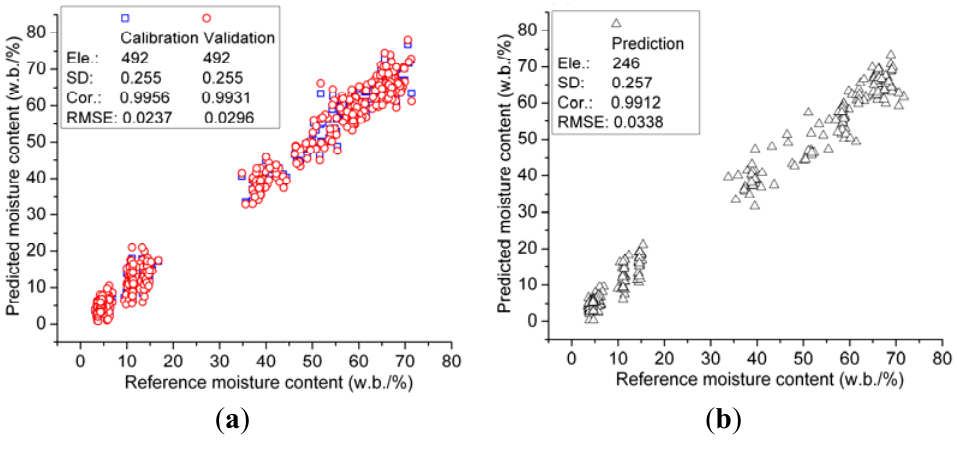
Figure 6. Scatter plot of reference vs . predicted of the optimal MLR Model 6 ( a ) calibration result and ( b ) prediction